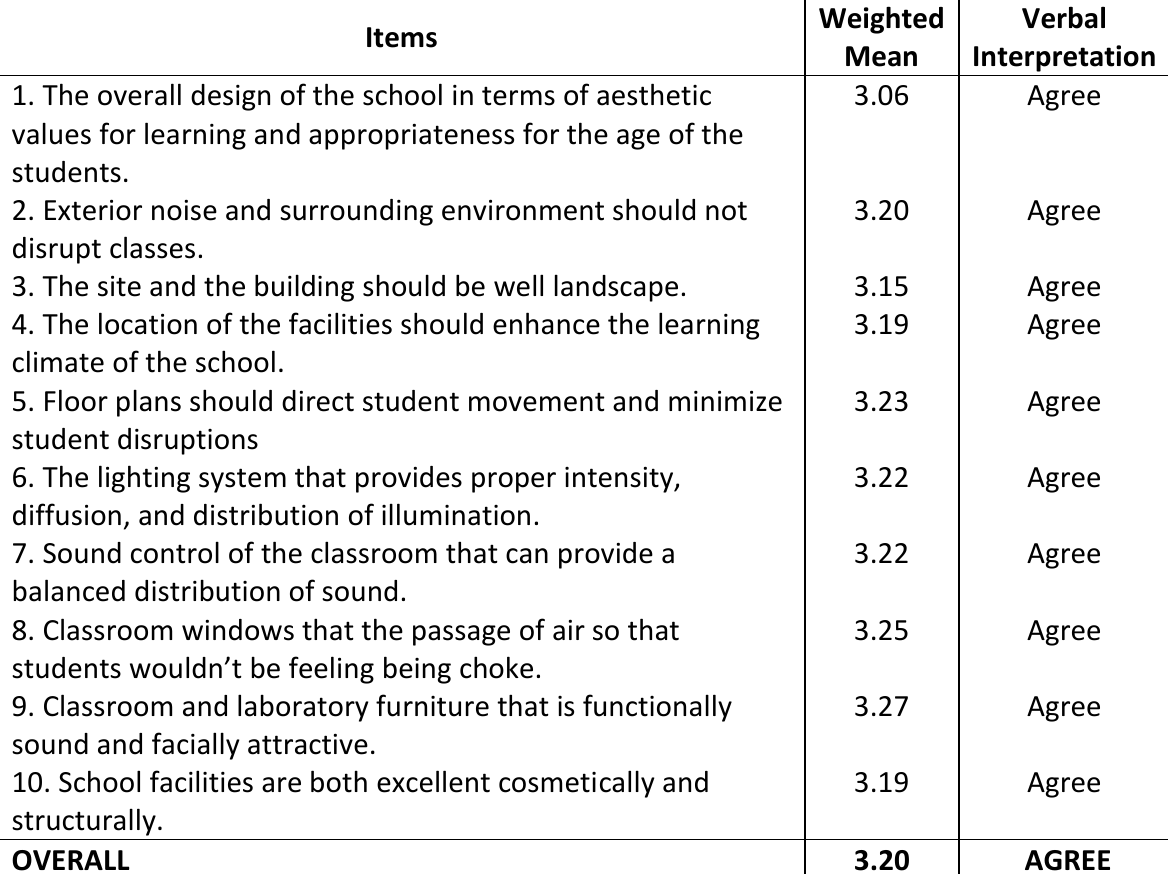
Table 10 : Weighted Means of the Factors Affecting Students’ Progress as to School